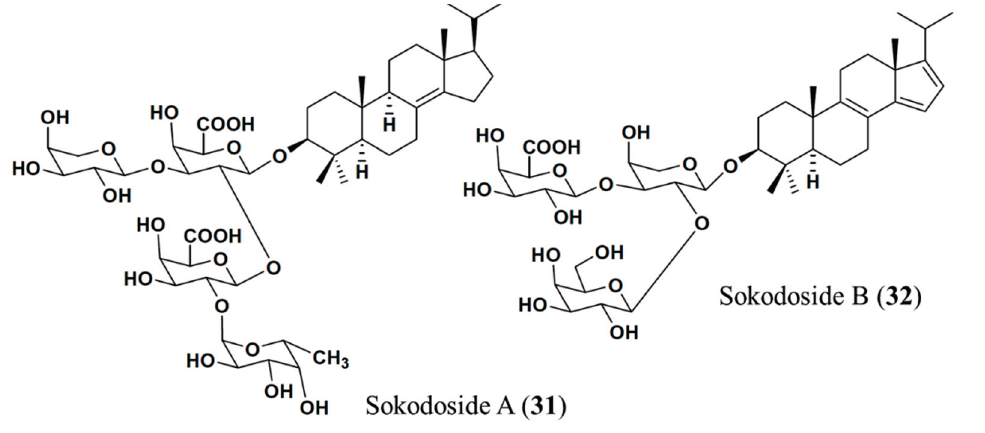
Figure 9. Sokodosides A ( 31 ) and B ( 32 ) isolated from marine sponge Erylus placenta